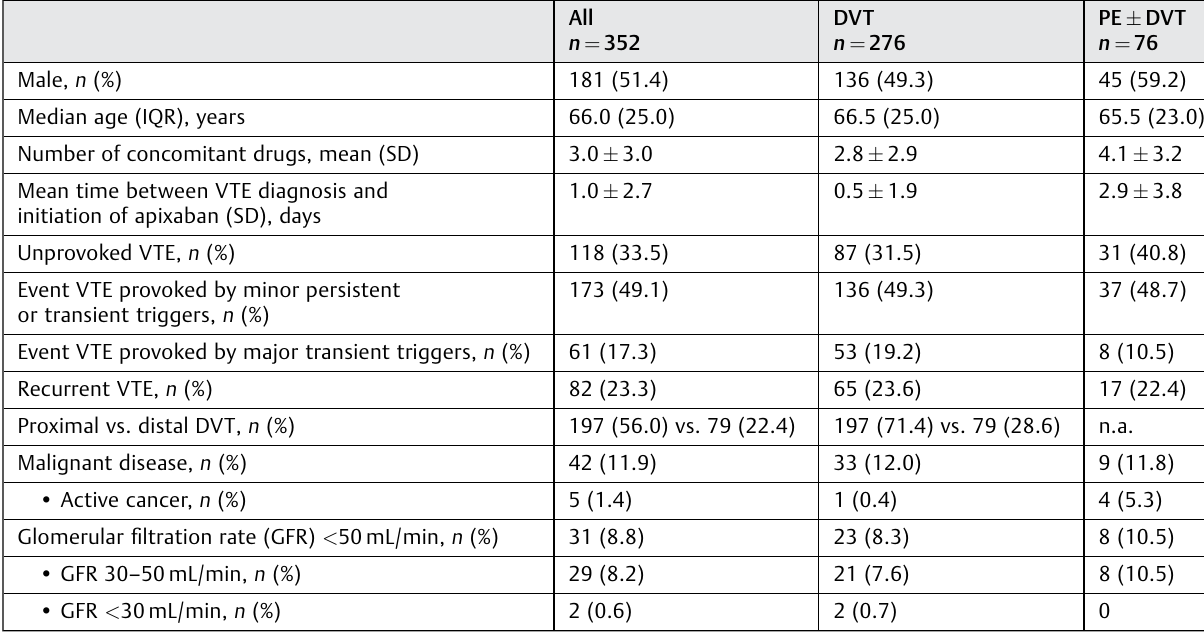
Table 1 Patient characteristics at baseline